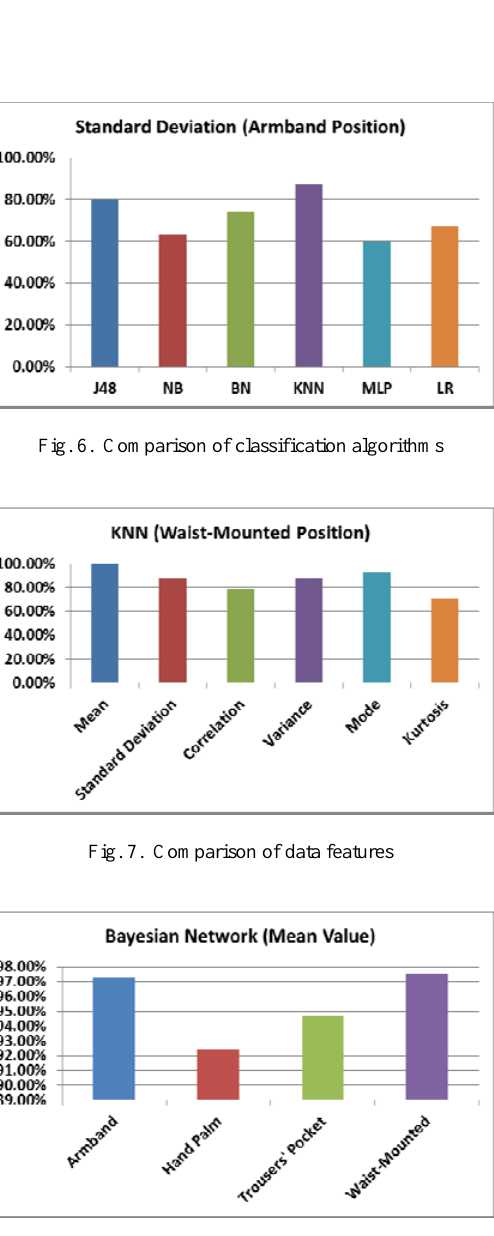
Fig. 8. Comparison of smartphone